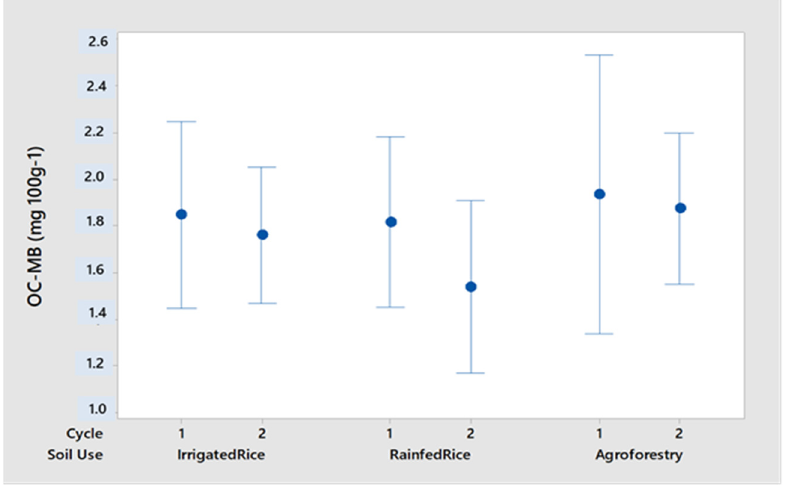
Figure 4. Interaction effect of the cycle and the stage on the organic carbon (OC) of microbial biomass (MB) ( n = 15).